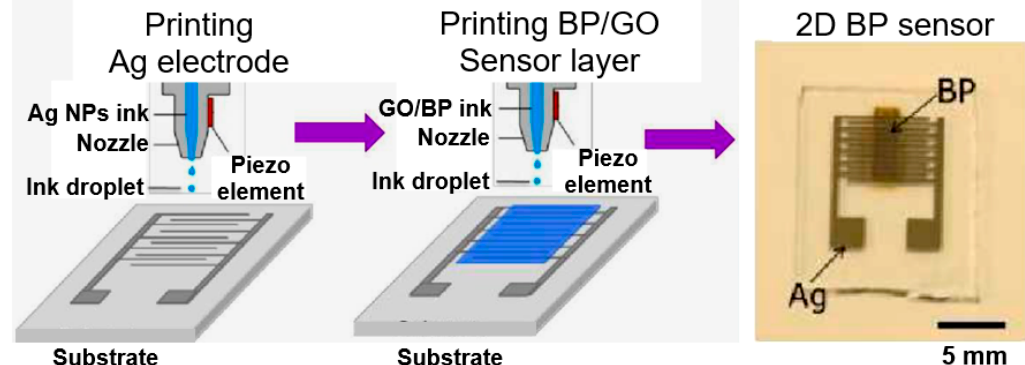
Figure 13. Schematic representation of the fabrication process of sensor device using inkjet printing technology. Reproduced with permission from Ref. [122]. Copyright RSC, 2018.